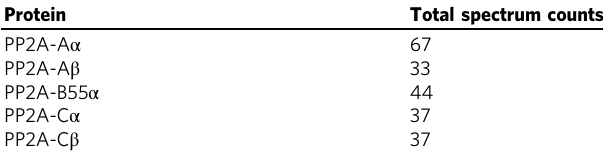
Table 1 Mass spectrometry analysis identi fi ed multiple PP2A subunits associated with mEya3 puri fi ed from HEK293FT